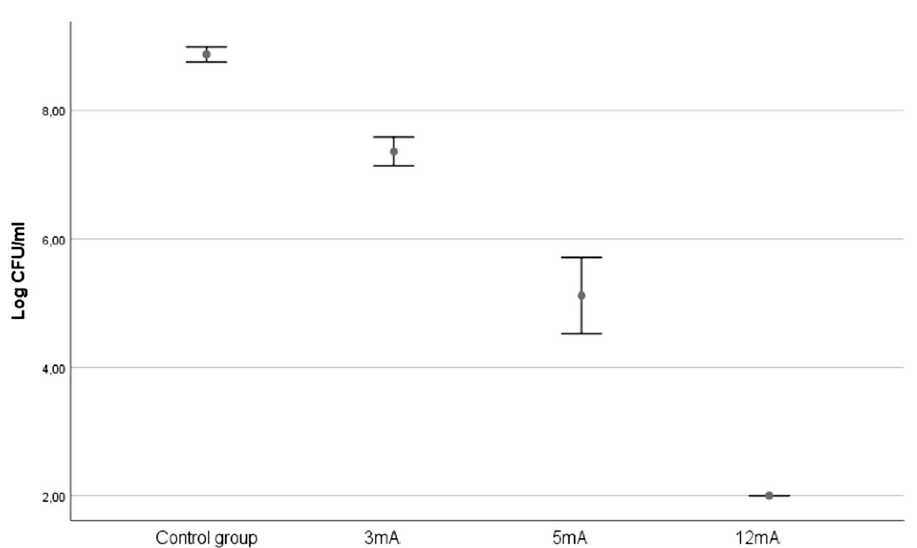
Figure 4. Complementary study of the effect of the application of different doses of galvanic current on a 9 Log 10 CFU/mL concentration of S. aureus in saline solution. All the doses were applied during 5 s and repeated 5 times. The error bars represent the CI